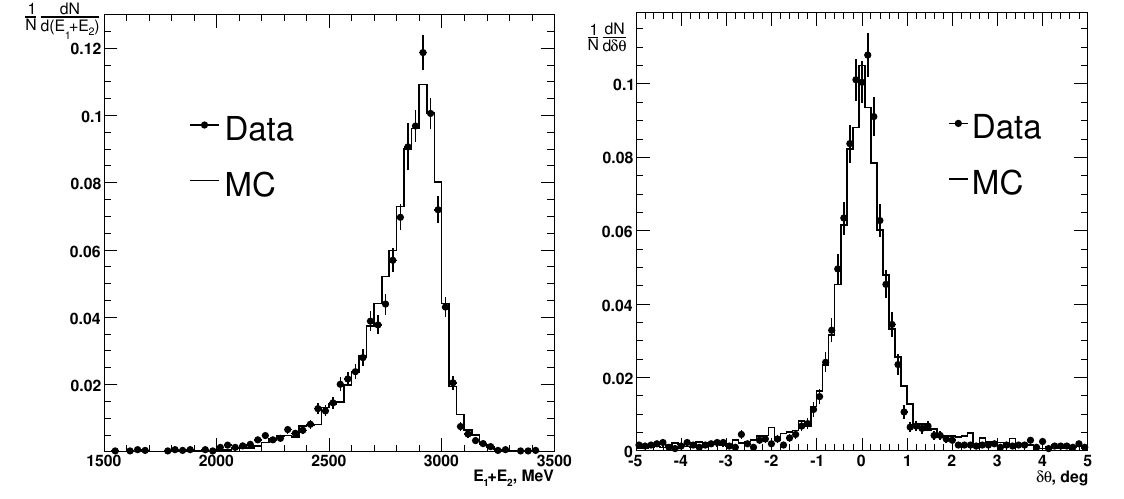
Figure 3 . Properties of e + e (cid:0) events produced at the J= peak at the c.m. energy 3097 MeV. Sum of two maximum cluster energies (left) and polar-angle acollinearity in degrees (right). All distributions are normalized to unity.